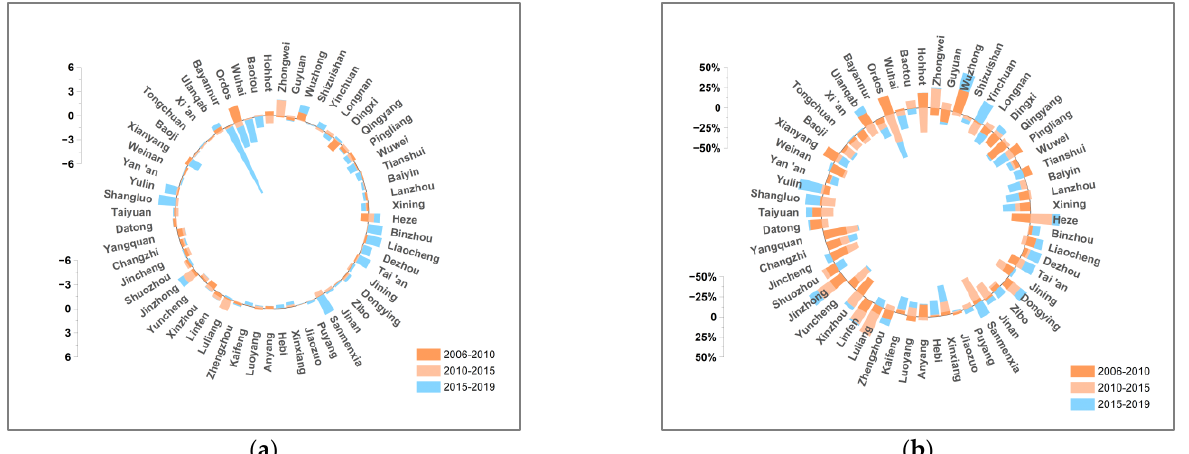
Figure 13. Contribution and contribution rate of power-structure factor. ( a ) Contribution of power-structure factor. ( b ) Contribution rate of power-structure factor.